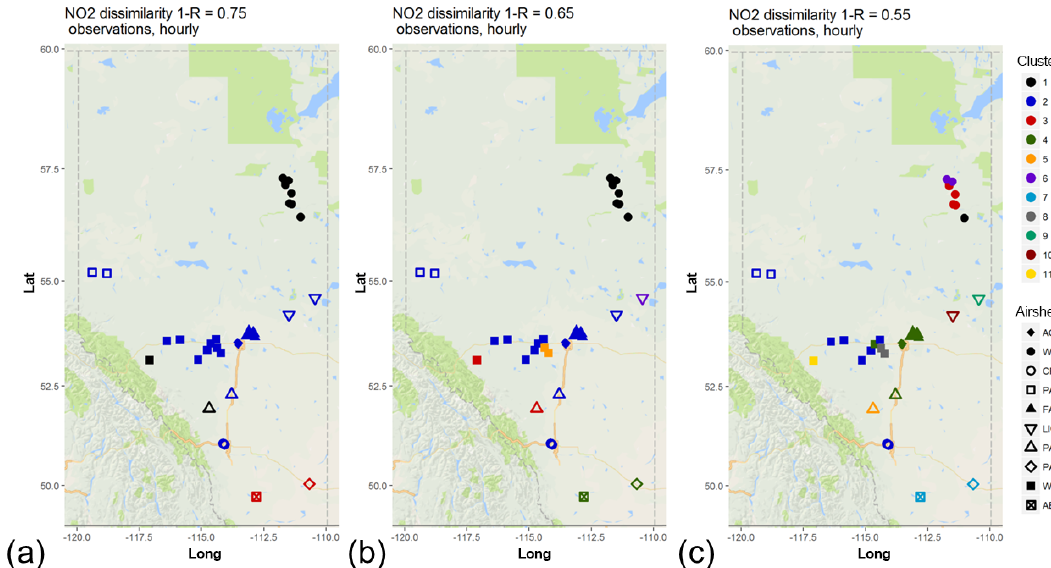
Figure 2. Associativity analysis for observed NO 2 hourly time series using 1 − R as the metric to compute the dissimilarity matrix, assuming a dissimilarity level of (a) 0.75, (b) 0.65, and (c) 0.55. Stations are colour-coded by cluster, and airsheds are plotted with different polygons. The acronyms for the airsheds are as in Fig. 1.